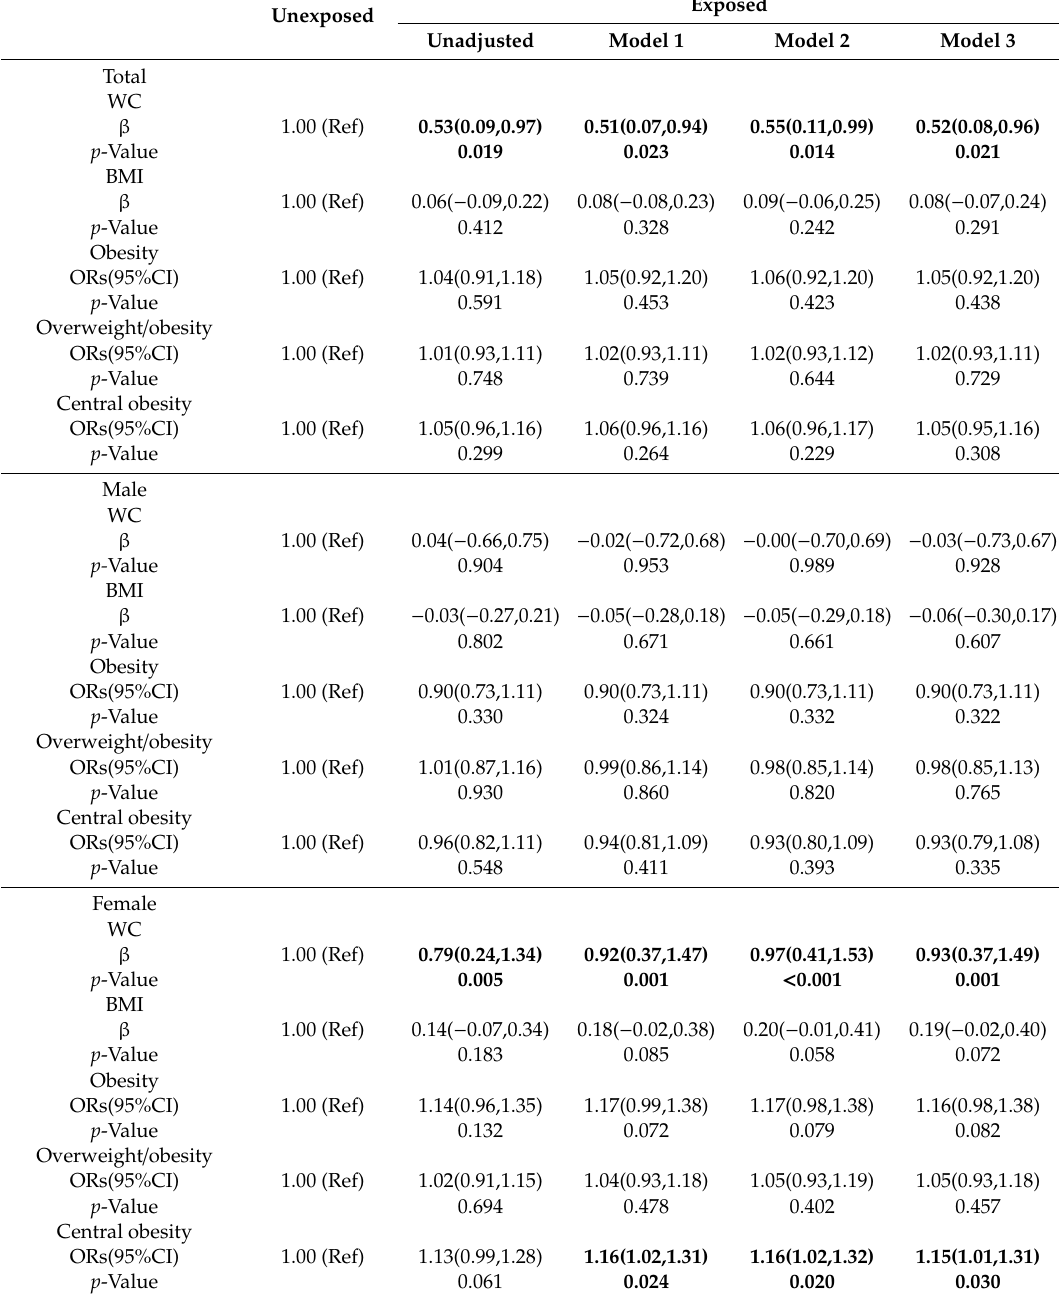
Table 2. Associations between fetal famine exposure and obesity